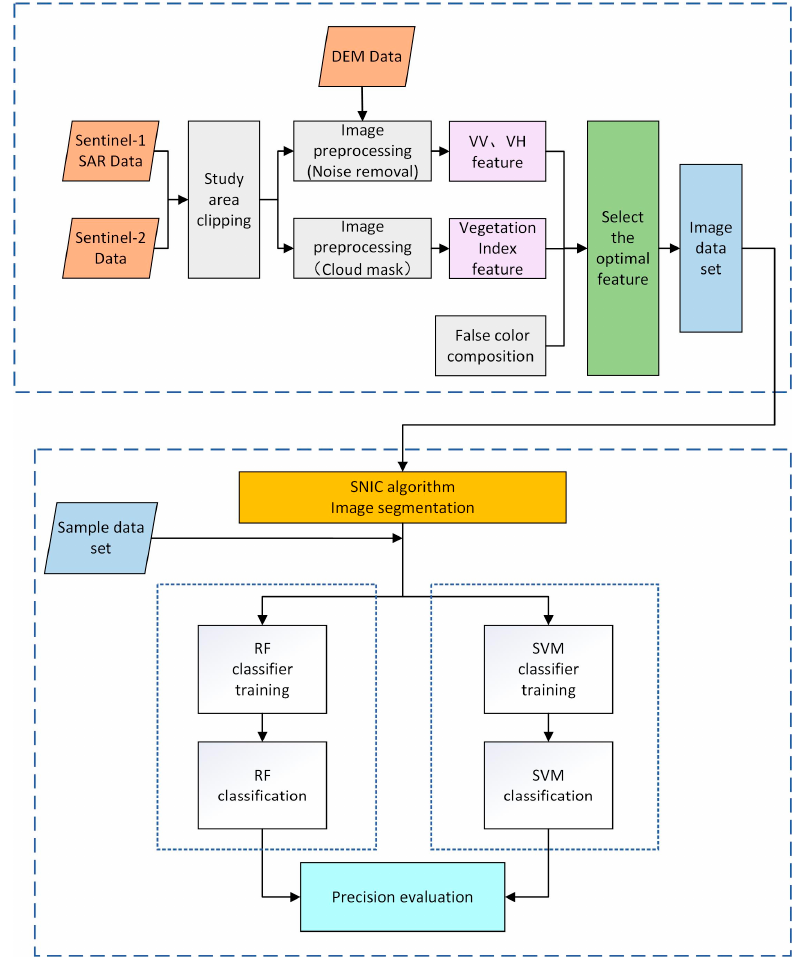
Figure 3. Research process.